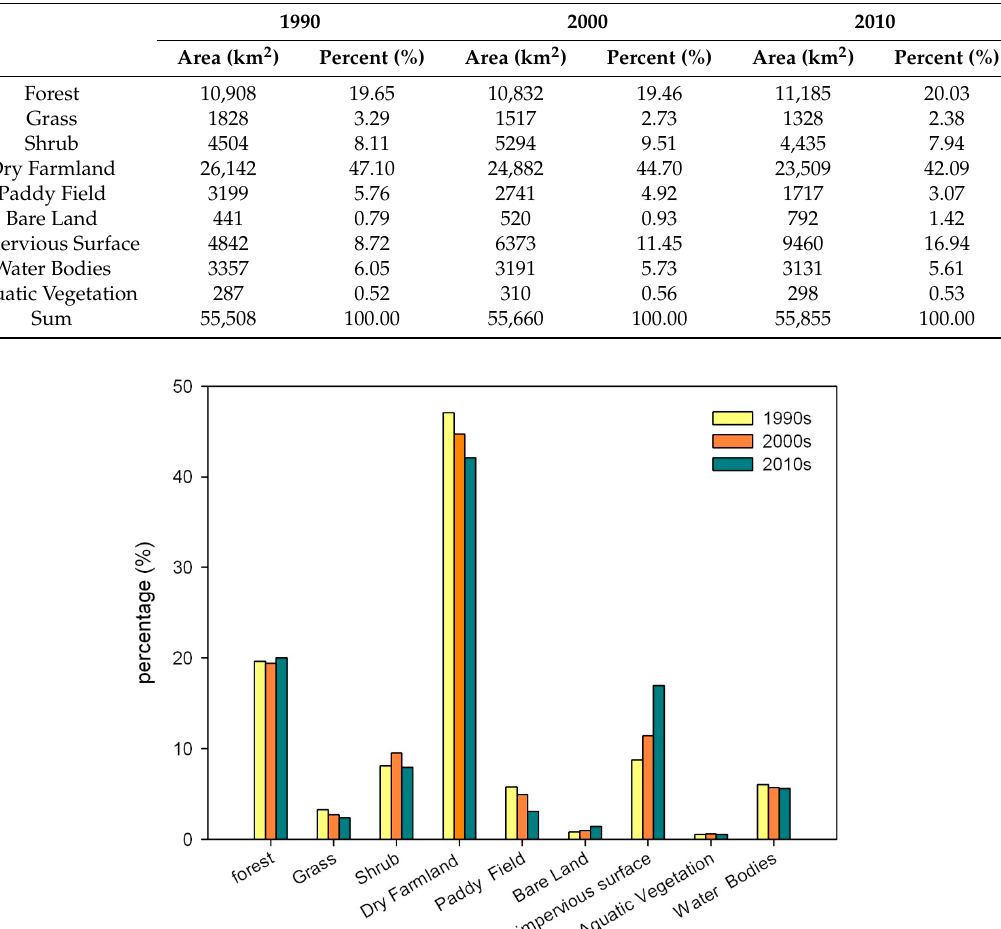
Table 4. Error-adjusted areas and proportions of the classes for the three periods.